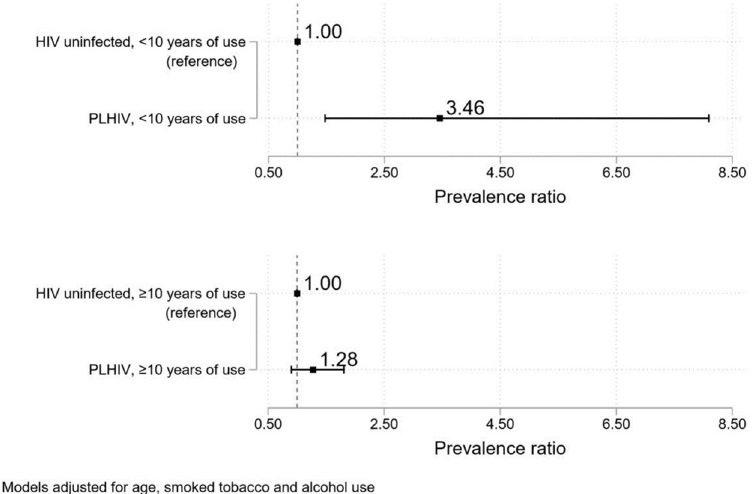
Fig 4. Adjusted prevalence ratios for suspected OPMDs among current smokeless tobacco users by HIV status and duration of